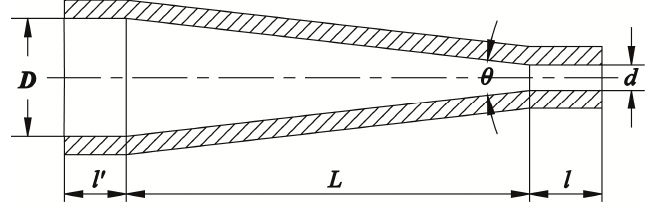
Figure 4. Schematic diagram of the straight cone nozzle structure.